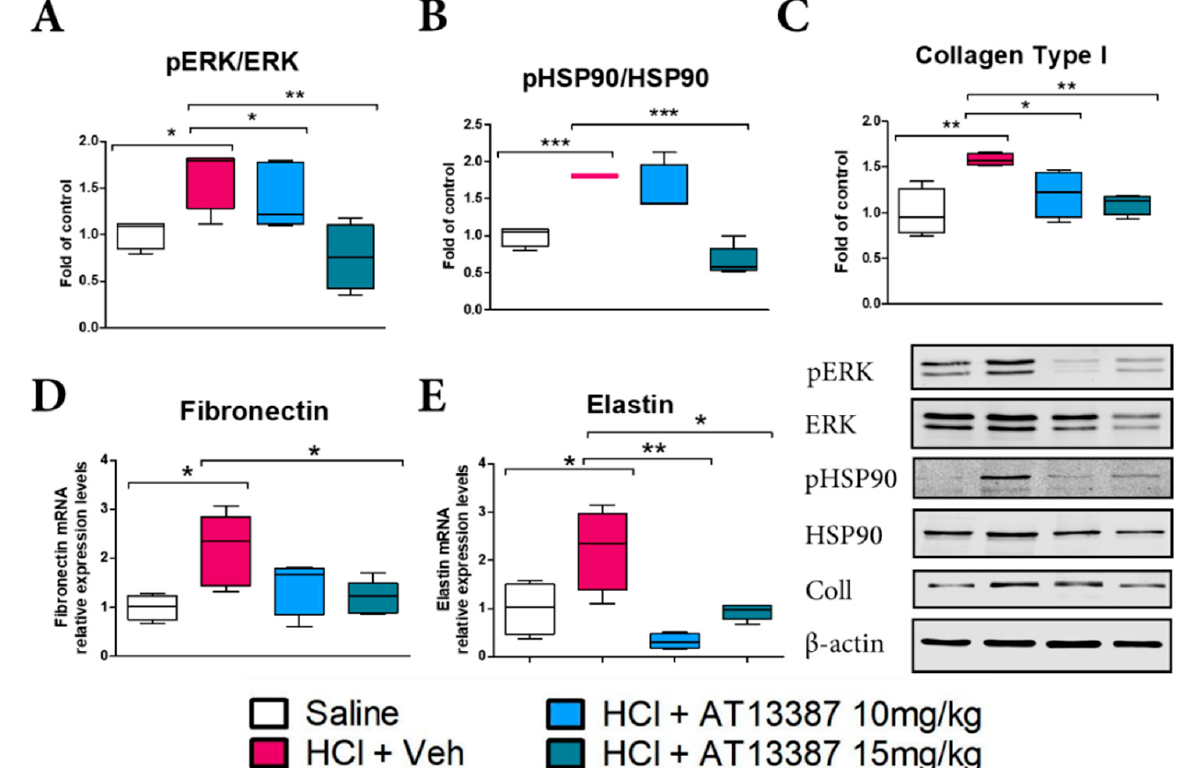
Figure 3. AT13387 prevents HCl-mediated fibrotic signaling and extracellular matrix deposition. AT13387 (at 10 or 15 mg/kg) reduced the activation (phosphorylation) of ERK1/2 ( A ), HSP90; ( B ), (15 mg/kg only), and Collagen ( C ) analyzed by Western blotting. All bands were normalized to β - actin. Relative expression levels of Fibronectin ( D ) and Elastin ( E ) mRNA were analyzed by RT- PCR. n = 4–5 mice per group; *: p < 0.05; **: p < 0.01, ***: p < 0.001, with 1-way ANOVA and Tukey’s.